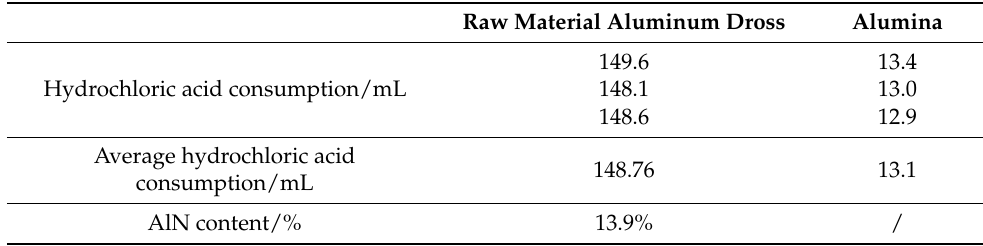
Table 2. Test results of AlN content in original recycled aluminum